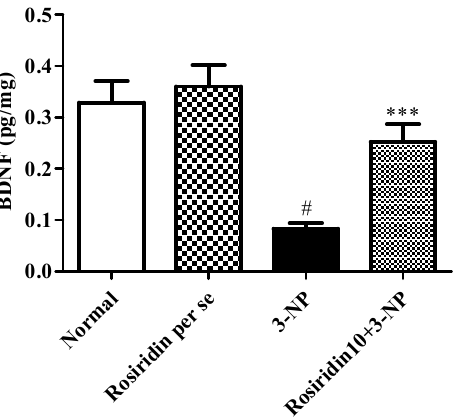
Figure 7. Effect of rosiridin on brain-derived neurotrophic factor (BDNF) activity. Values are expressed as the mean ± SEM (n = 6). Values are statistically significant at p < 0.05 (one-way ANOVA followed by Dunnett’s test). Express the data ( # p < 0.05) saline vs. negative control group; (*** p < 0.001) negative control group vs. treatment group.